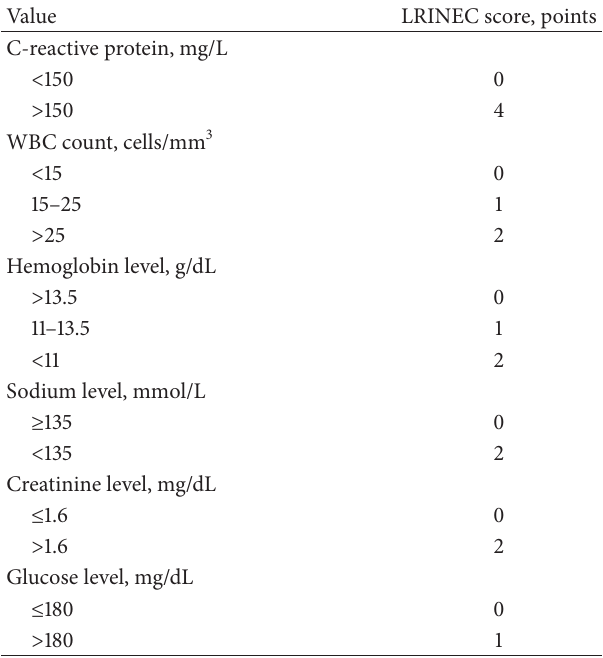
Table 1: LRINEC scoring system to help discriminate between necrotizing and nonnecrotizing soft tissue infections [2].